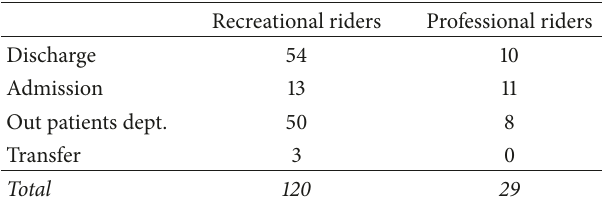
Table 4: Comparison in outcome of presentation between recre- ational and professional